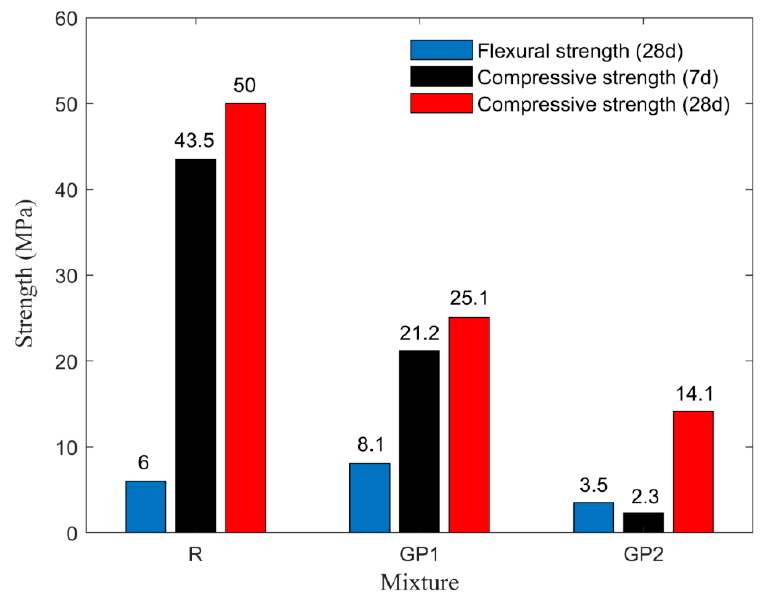
Figure 6. The flexural and compressive strength test results of the produced composites. Table 9. Characteristics of the prepared composites: R: reference concrete, GP1: metakaolin-based geopolymer composite and GP2: stream-based geopolymer composite. R GP1